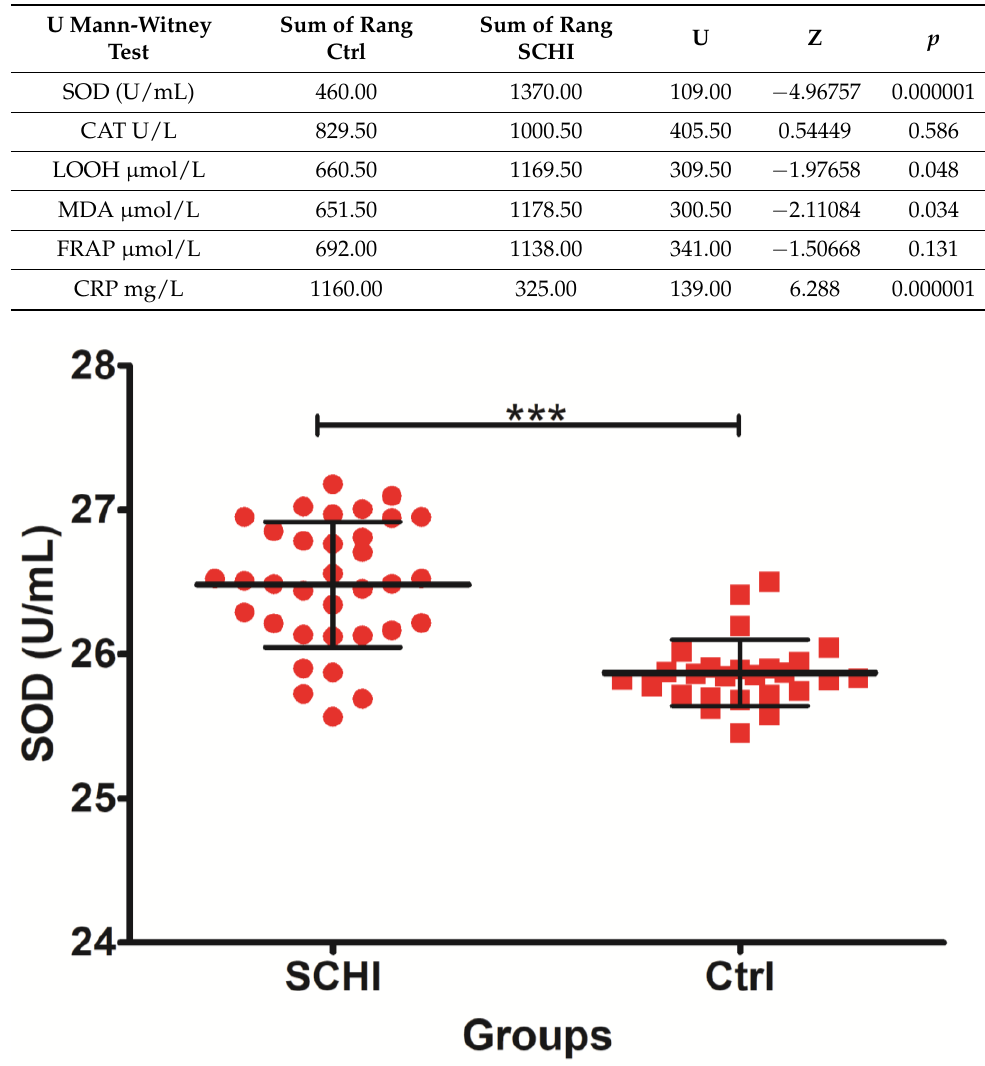
Figure 1. Levels of plasma superoxide dismutase SOD in schizophrenia group patients and healthy controls. *** indicates p -value < 0.0001.